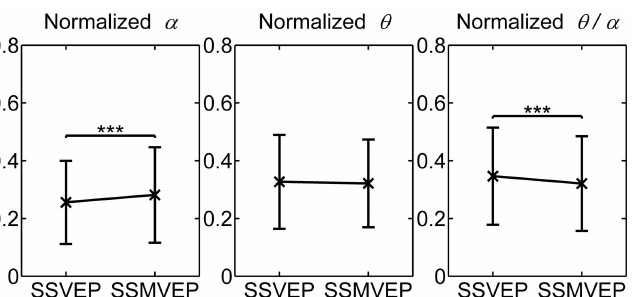
Fig 2. Comparison of the mean values and SD of mental load score between flickering SSVEP-BCI and motion-reversal SSMVEP-BCI task conditions over subjects. The mean values and SD of the normalized power indices α and θ and ratio index θ / α were calculated from evoked EEG over nine subjects. Horizontal axis: SSVEP—flickering SSVEP-BCI task condition; SSMVEP—motion-reversal SSMVEP-BCI task condition. All statistics were assessed by one-way ANOVA, *** p < 0.001 between evoked EEG in SSVEP-BCI and SSMVEP-BCI